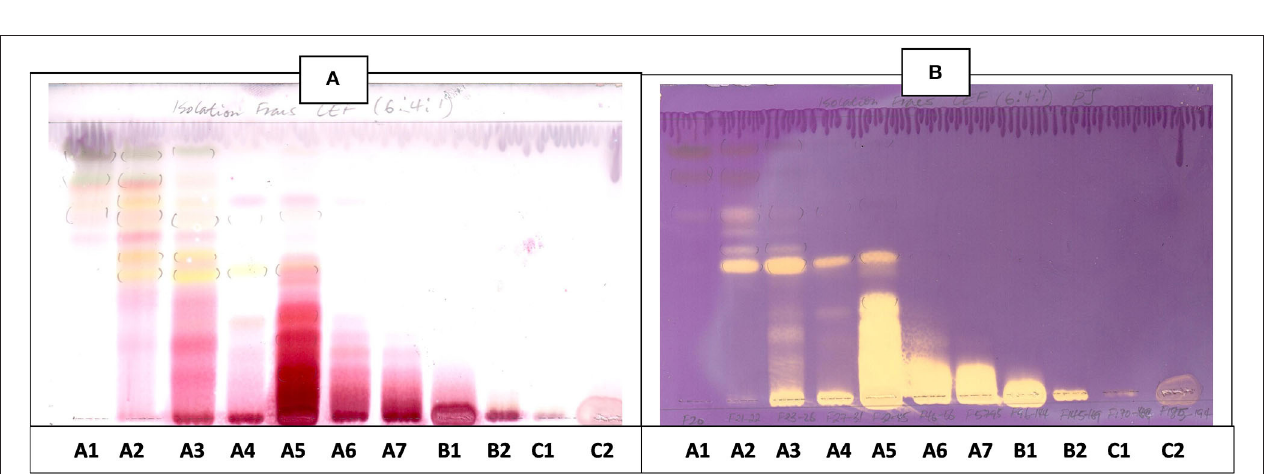
Where A1 is the absorbance of the control reaction and A2 is the absorbance in the presence of the sample. Trolox and ascorbic acid were used as controls. The experiments were conducted